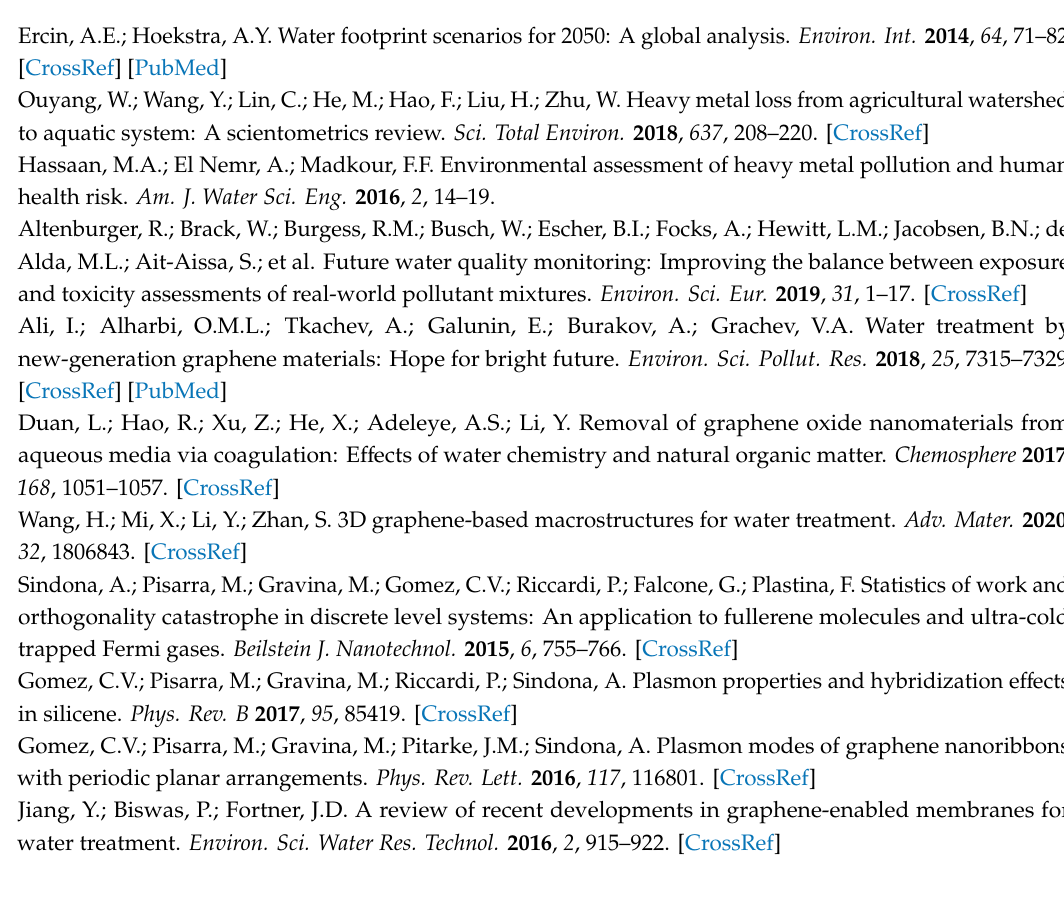
Figure S1: UV-Vis spectra recorded in aqueous solutions at 0.1 mg / mL of rGO considering di ff erent reduction times (0.5 h, 1.0 h and 1.5 h). The intensity was normalized by the predominant peak; Figure S2: Optical image for adsorption of MB onto rGO at T = 298 K. The MB-rGO suspension was centrifugated at 3000 rpm for 5 min after 30 min of contact time; Figure S3: Experimental adsorption isotherms for the removal of MB at di ff erent